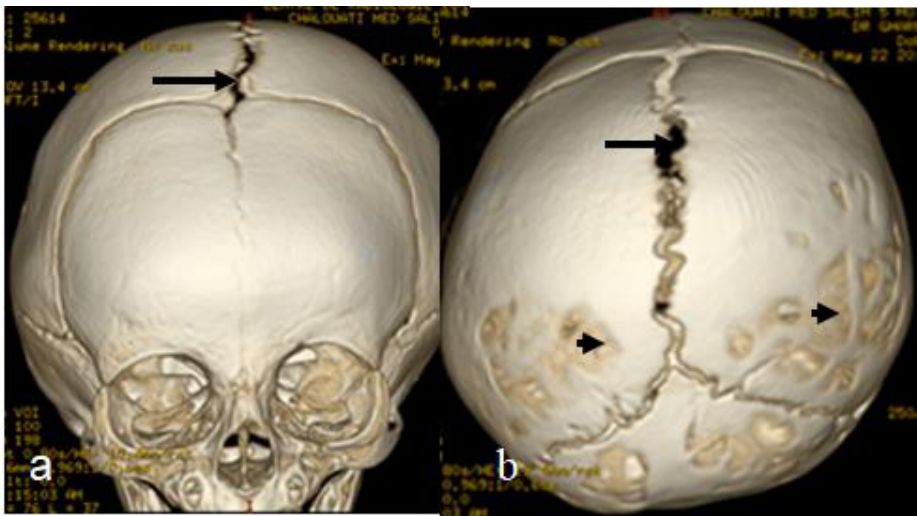
Figure 5. Three-dimensional reconstruction CT scan of the skull (anterior view) of a 2-year-old boy with RSS showed the frontal bossing and the persistent open anterior fontanelle-(arrow) ( a ); Three- dimensional reconstruction of the crown of the skull of the same boy showed defective ossification of the anterior fontanelle and defective and disorganized ossification of the skull bones (arrow heads) ( b ).